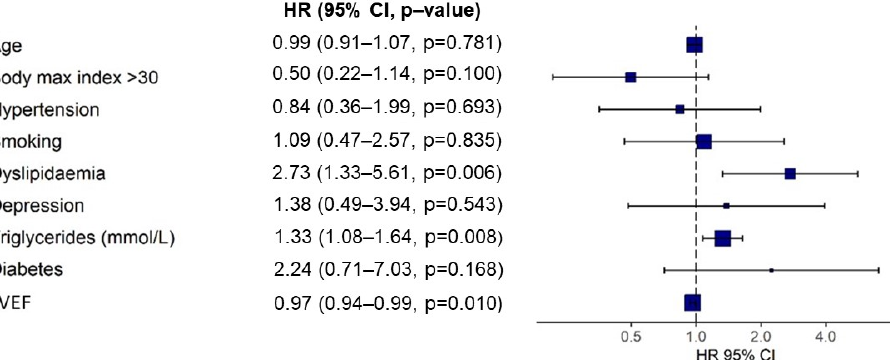
Figure 5. Cox regression model of risk factors associated with MACE at follow-up. LVEF: Left ventricular ejection fraction.